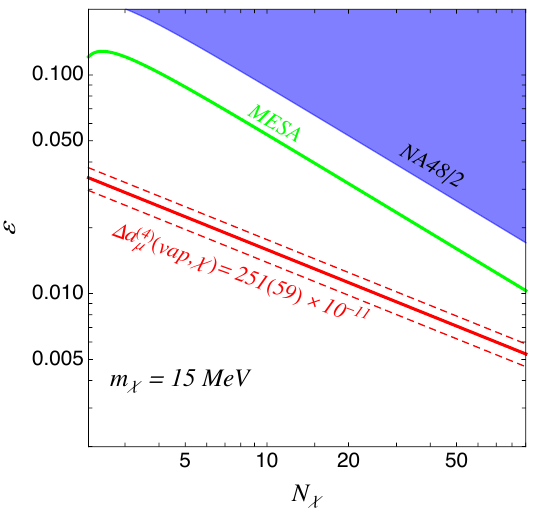
Figure 4 . The parameter space in ε and N χ for the millicharged confining SU( N χ ) model. The light blue region is excluded by the NA48/2 experiment [38], while the green line is the projected limit from MESA